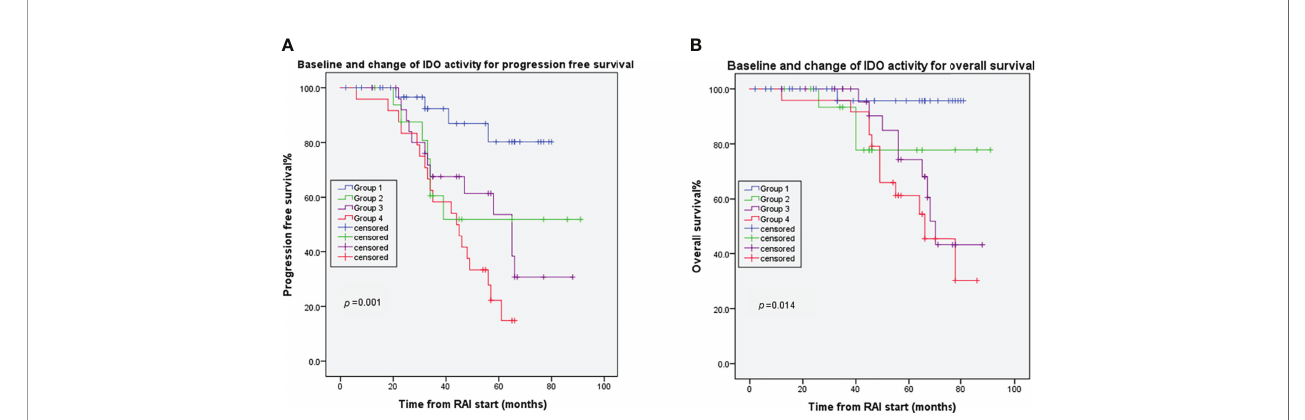
FIGURE 4 | Combined effects of baseline Change of IDO on DTC tumor progression (A) and overall survival (B) . Group 1: patients with low baseline K/T ratio and low post/pre-kynurenine ratio; Group 2 patients with high baseline K/T ratio and low post/baseline kynurenine ratio; Group 3: patients with low baseline K/T ratio and high post/baseline kynurenine ratio; Group 4: patients with high baseline K/T ratio and high post/baseline